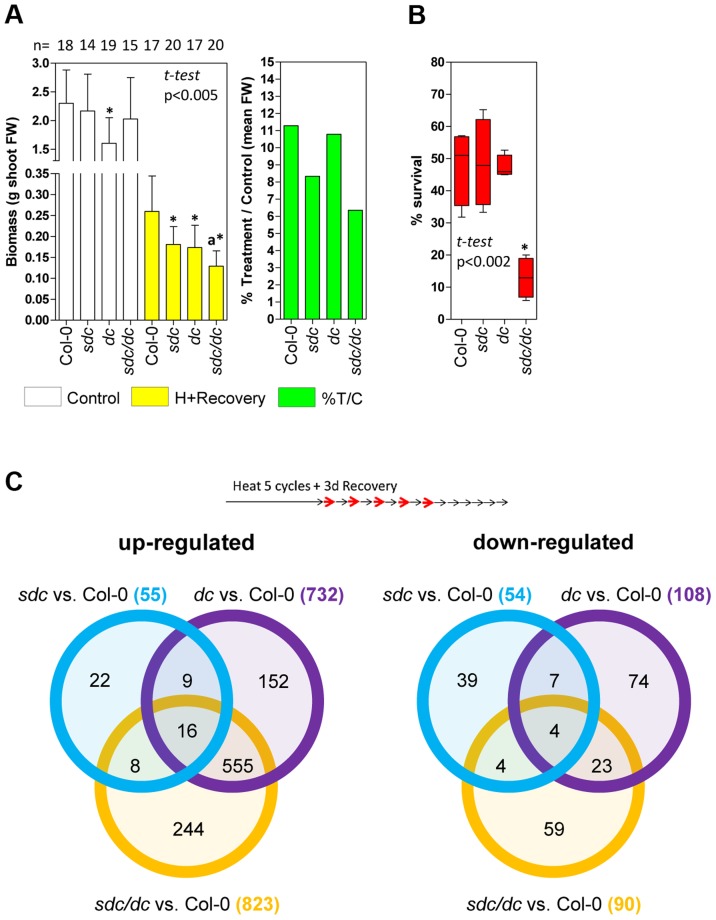
Physiological and transcriptomic data for sdc, dc and sdc/dc mutants.
A, Left: Physiological tolerance measured as final aerial biomass. Bars represent means ± SD of shoot fresh weigh (FW) of controls and plants treated for 15 heat cycles plus 18 days of recovery under standard conditions. Numbers at the top represent the independent plants tested.* means statistically significant to the corresponding wild type Col-0 control, and a means statistically significant to the dc heat + recovery plants (P<0.005, Student t-test). Right: Relative mean aerial biomass as percentage of controls obtained from the data shown on the left, denoting a decrease of at least 30% in relative biomass after treatment of genetic backgrounds harboring the sdc mutation. B, Survival to moderately high temperatures, expressed as percentage of seedling survival after 7 days of continuous heat treatment at 35°C from four independent biologically replicated pools of 30–50 seedlings. Data are depicted as box plots. * means statistically significant to wild type Col-0 (P<0.002, Student t-test). C, Venn diagrams comparing differentially regulated genomic features in the sdc, dc and sdc/dc mutants. Transcriptome analysis was performed in duplicated biological samples after a 5 heat-cycle entrainment +3 days of recovery (experimental design shown at the top). Venn diagrams show up- or down-regulated genomic features for each mutant compared with the wild-type. Within the diagrams, the numbers represent differentially regulated genomic features either unique or shared, whereas the legend brackets show the total number of up- or down-regulated genomic features.